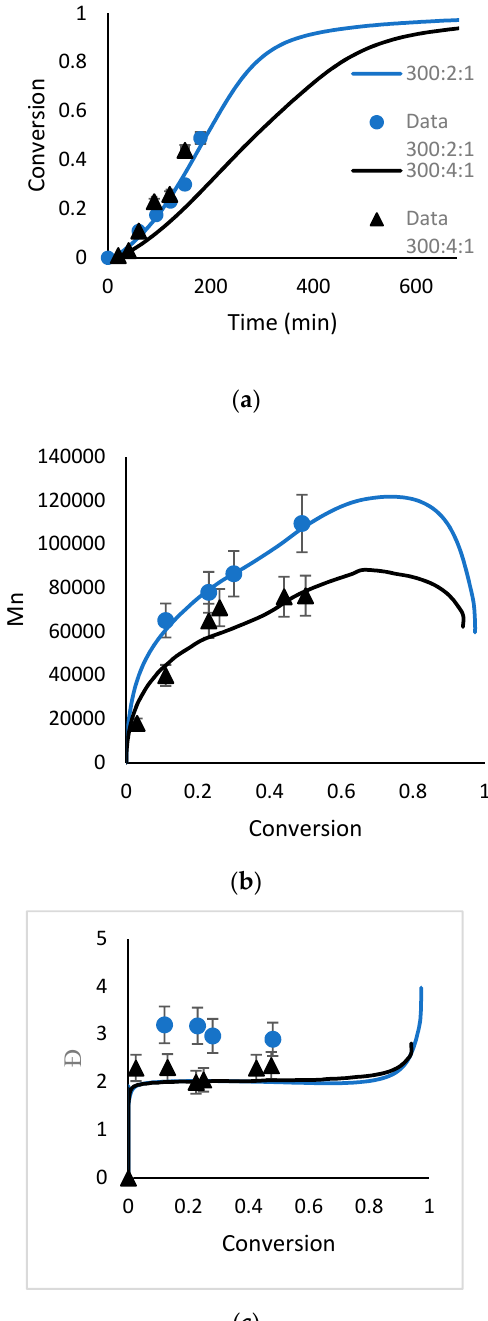
Figure 11. Comparison of model predictions and experimental data for ( a ) monomer conversion versus time, ( b ) number average molar mass versus conversion, and ( c ) Ð versus conversion. [MMA]:[dihydro-2(3)-thiophenethione (DTL2)]:[AIBN] = 300:2:1 for EXP 1 and 300:4:1 for EXP 2.